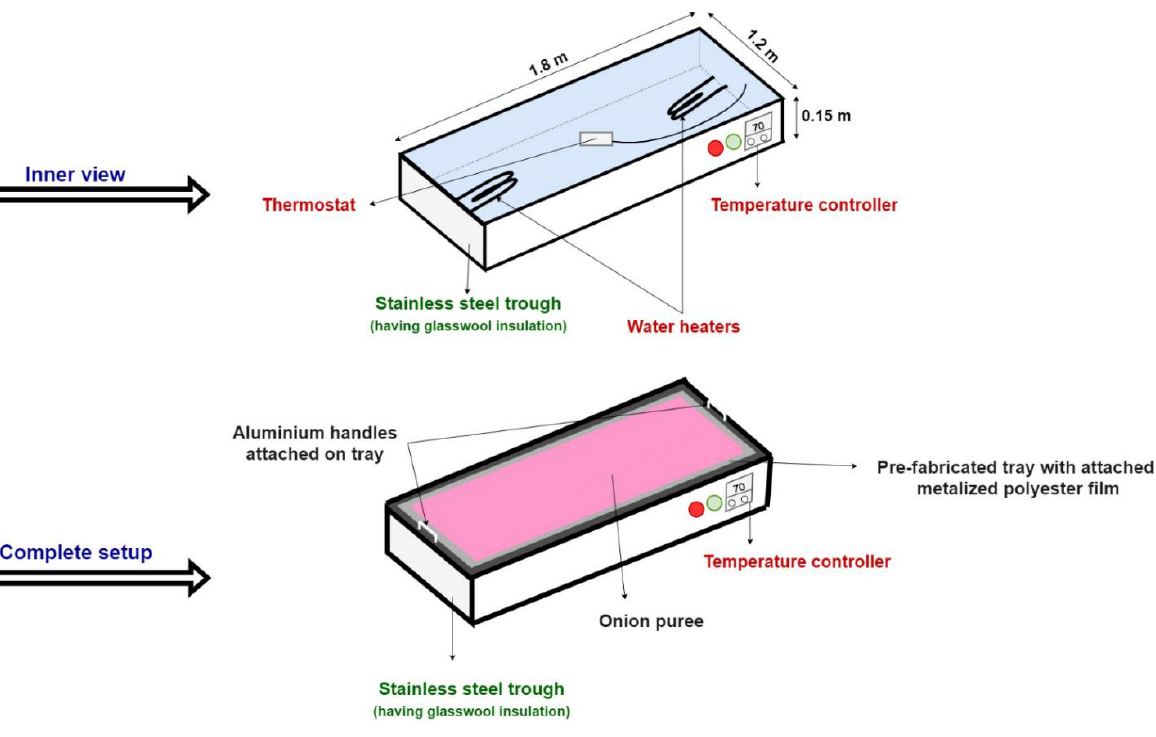
Figure 1. Schematic diagram of the refractance window